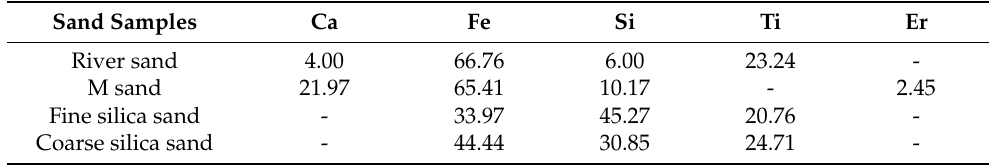
Table 2. Elemental composition of sand samples